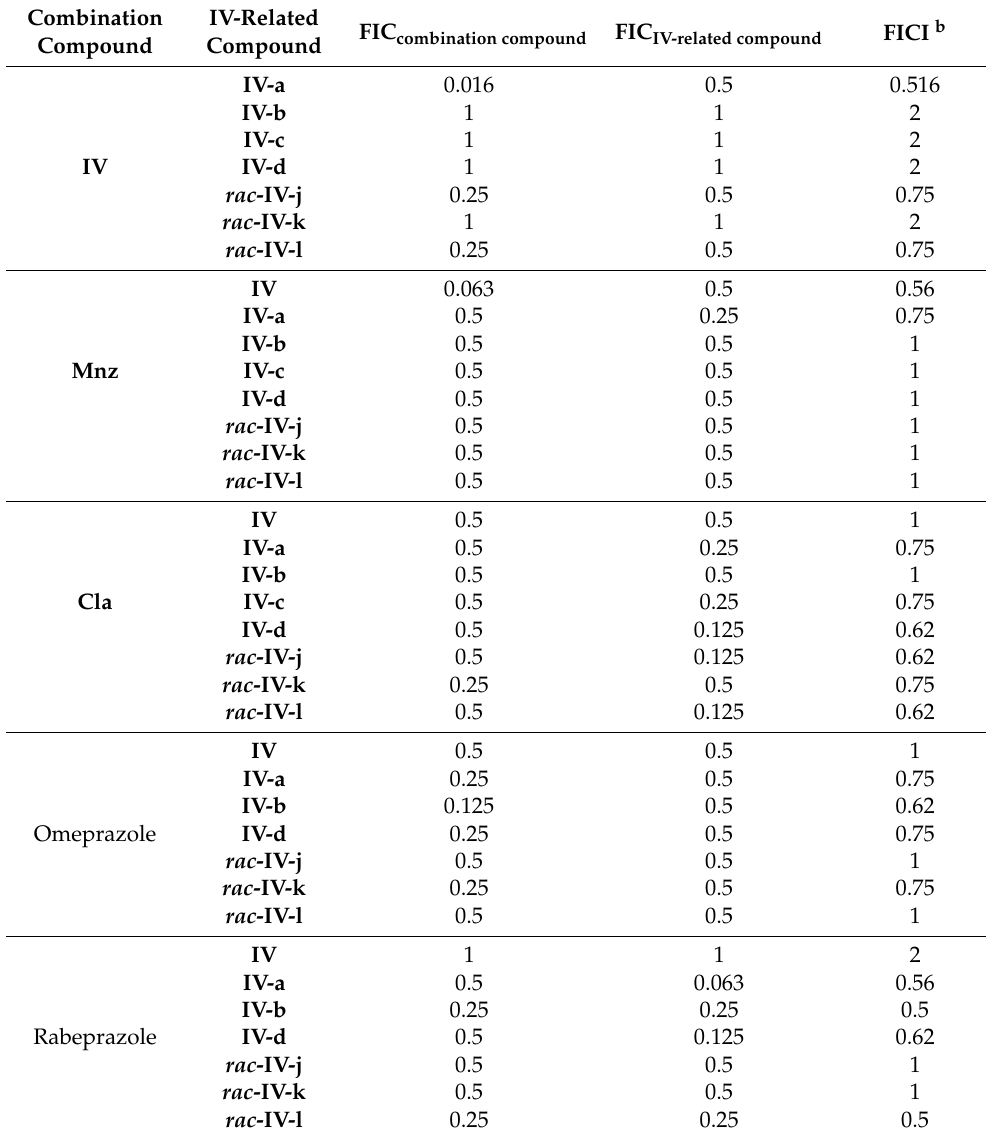
Table 4. FICs and FICIs of IV-related compounds in combination with either IV , Mnz , Cla , omepra- zole or rabeprazole a